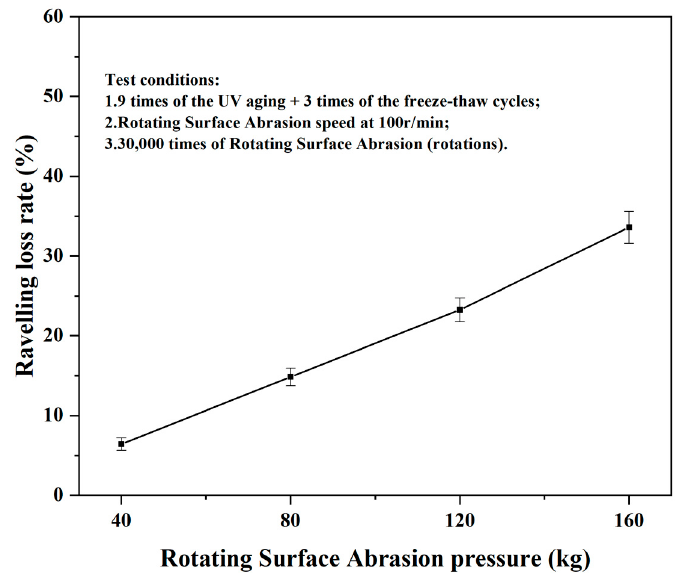
Figure 9. Simulated vehicle load impact test.